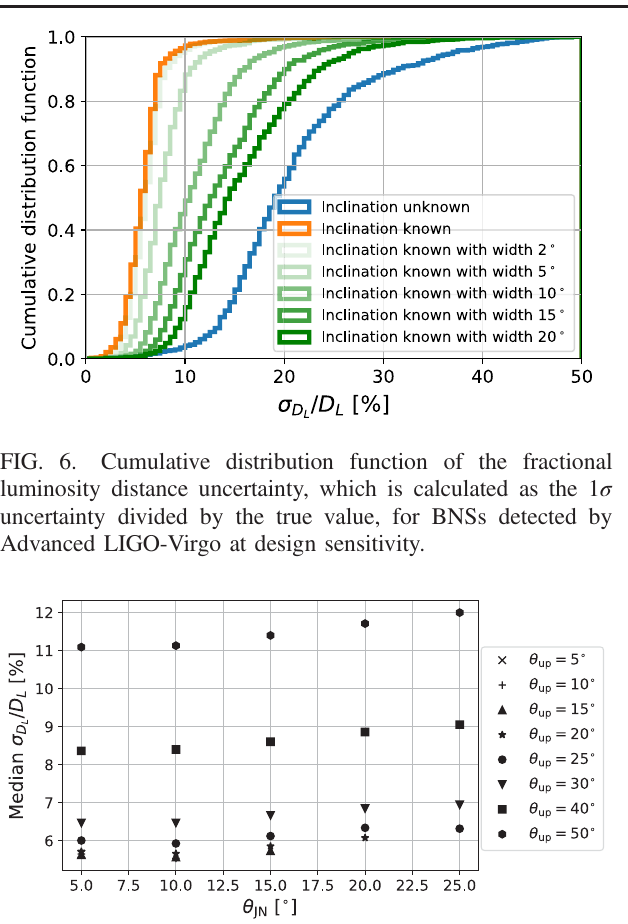
FIG. 7. Median value of the fractional luminosity distance uncertainty assuming the viewing angle is bounded by the EM observations of BNSs detected by Advanced LIGO-Virgo at design sensitivity. Each point represents the median uncertainty of 1000 BNSs with inclination angle θ and an EM upper bound JN of θ up